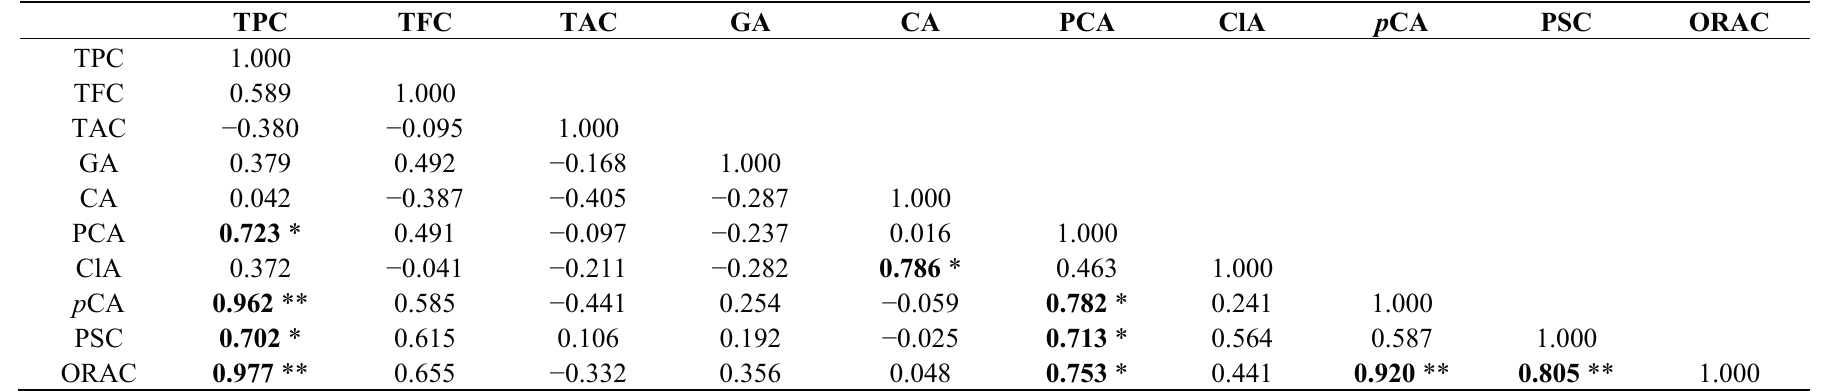
Table 6. Correlation coefficient matrix between phenolics content and antioxidant properties in mango